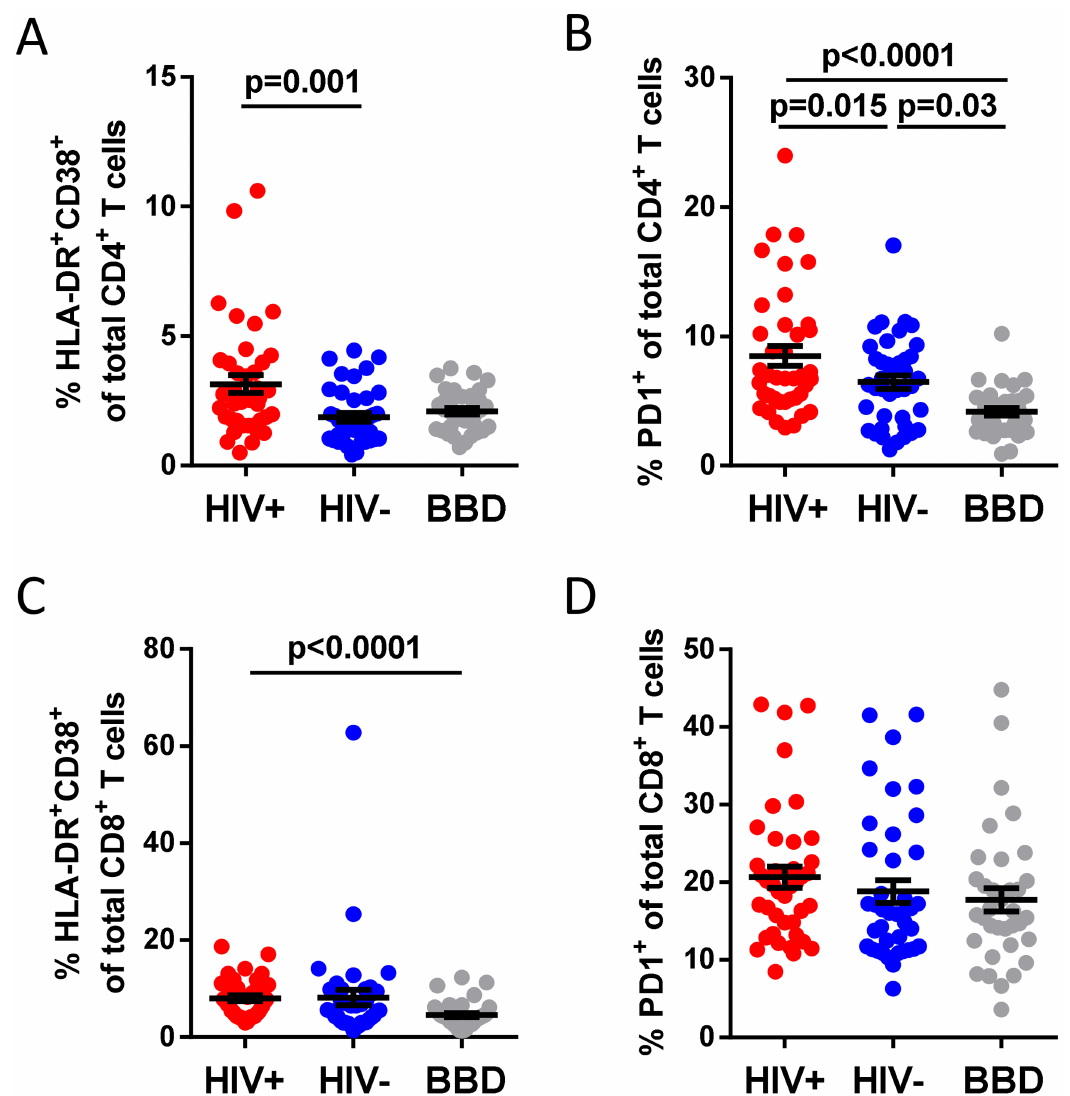
Fig 1. CD4 and CD8 T cell activation and exhaustion in HIV-positive and HIV-negative COBRA participants, and blood bank donors. (a) The percentageof activated (HLA-DR + CD38 + ) and (b) exhausted(PD-1 + ) CD4 + T cells within the CD4 + T-cell population.(c) The percentageof activated (HLA-DR + CD38 + ) and (d) exhausted(PD-1 + ) T cells within the CD8 + T-cell population.Significance was assessedwith multivariable linear regression,corrected for age and gender. HIV+, HIV-positive; HIV-, HIV-negative; BBD, blood bank donors.